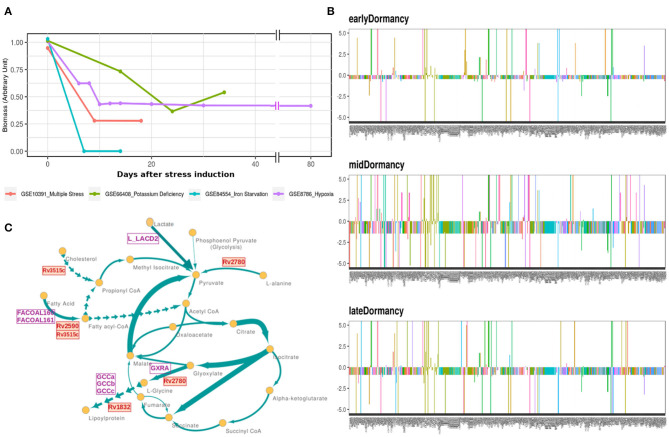
(A) Optimal flux through the hypothetical biomass reaction from iEK1011 in different timepoints of all the models showing a significant reduction in biomass generation in dormancy compared to exponential growth. (B) Flux fold change of all non-zero reactions in Potassium deficiency model of dormancy at 3 different stages in comparison to the exponential growth phase. X axis in each contains the reactions with non-zero fluxes and Y axis shows the fold change value. Most of the reactions are downregulated during dormancy. (C) A representative subgraph of metabolic pathways focused on the TCA-glyoxylate cycle of central carbon metabolism in dormant state Mtb in multiple stress induced model. The thickness of the edges is directly proportional to flux through the reactions. Yellow circles signify metabolites. Purple squares indicate reactions from the 14 commonly upregulated reactions across dormancy models. Red squares highlight the genes eventually identified as drug target candidate further down the pipeline.